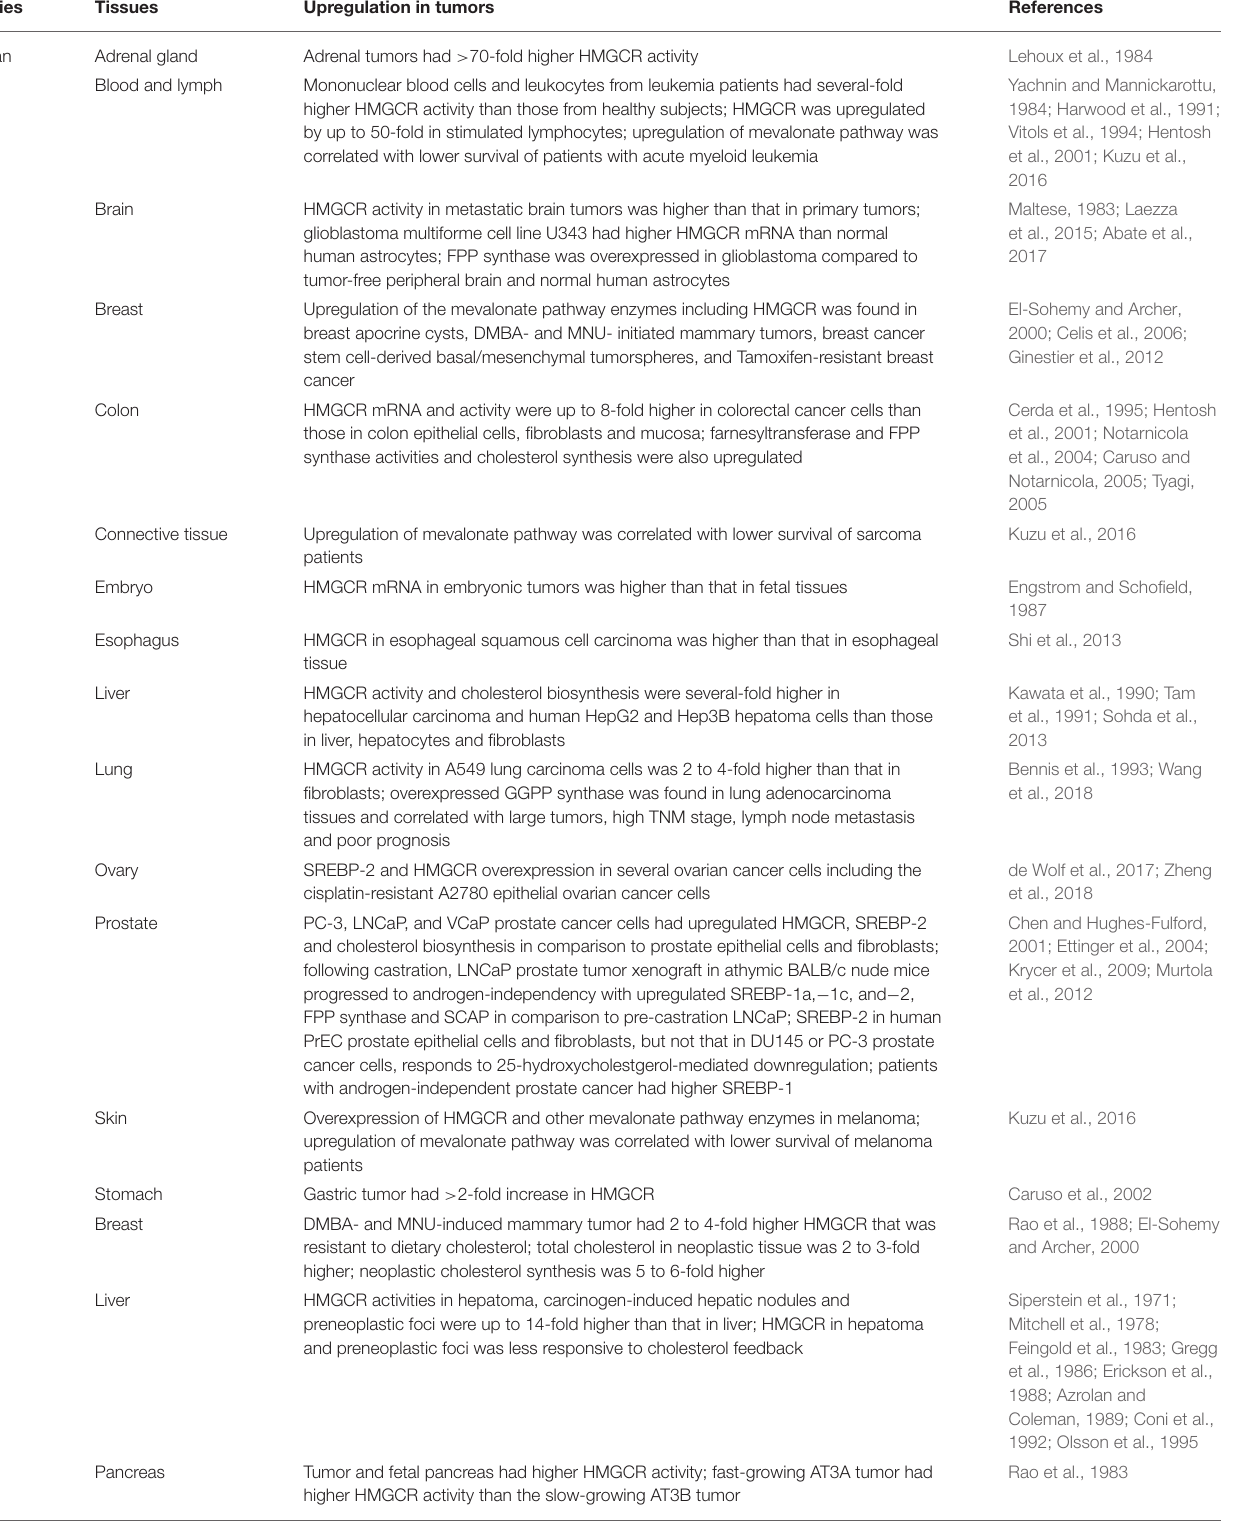
TABLE 1 | Overexpression of HMGCR and upregulation of mevalonate pathway activities in tumors.